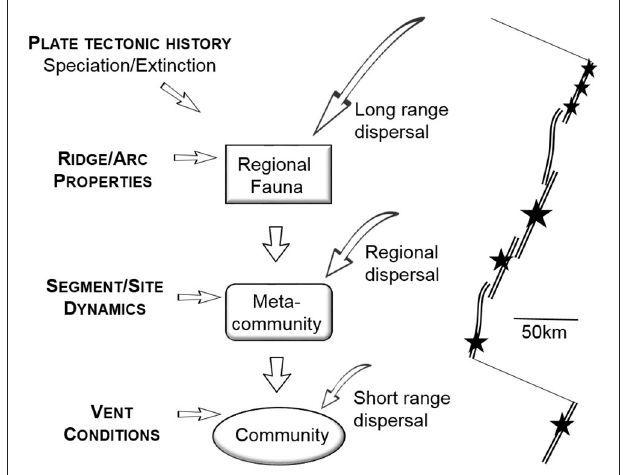
FIGURE 4 | Influences on vent fauna over a spectrum of spatial and temporal scales (decreasing from top to bottom). Globally, vent biogeography is constrained by plate tectonic history, and associated speciation and extinction events. Species assemblage of a region is determined mostly by tectonic behavior and development of inter-region barriers. However, rare dispersal from afar can affect the regional fauna. Ridge/arc properties, such as spreading rate and magmatic budget, are manifested at the regional and sub-regional scales, affecting metacommunity composition through the distribution and stability of venting. Variation in habitat suitability at the patch scale (e.g., fluid chemical composition) affects species composition of individual communities. The example at right of ridge segmentation (double lines) in the eastern Pacific illustrates potential barriers to dispersal such as transform faults (single lines) and non-venting segments that lack suitable habitat (stars are vent fields). The spatial extent of a vent metacommunity will depend on connectivity as mediated by vent site